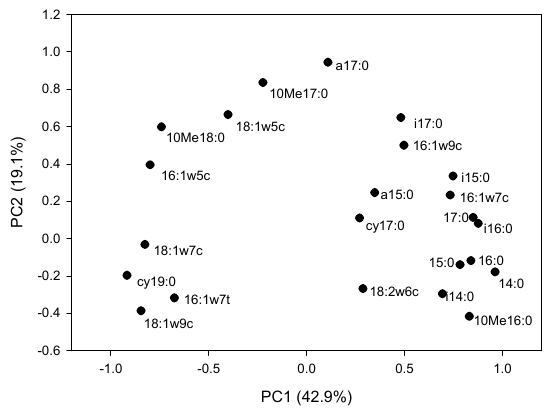
Figure 2. Corresponding loading values from the principal component (PC) analysis of the mole % microbial phospholipid fatty acid content in soil samples from three forest types in summer. Table 3. Soil enzymatic activities in 40 ‐ year ‐ old (CONIF ‐ 40) and 80 ‐ year ‐ old (CONIF ‐ 80) coniferous forest plantations and a natural broadleaf forest (BROAD ‐ Nat) in two seasons. Table 4. Contents of phospholipid acid biomarkers (nmol · g − 1 soil) and biomarker content ratios in 40-year-old (CONIF-40) and 80-year-old (CONIF-80) coniferous forest plantations and a natural broadleaf forest (BROAD-Nat) in two